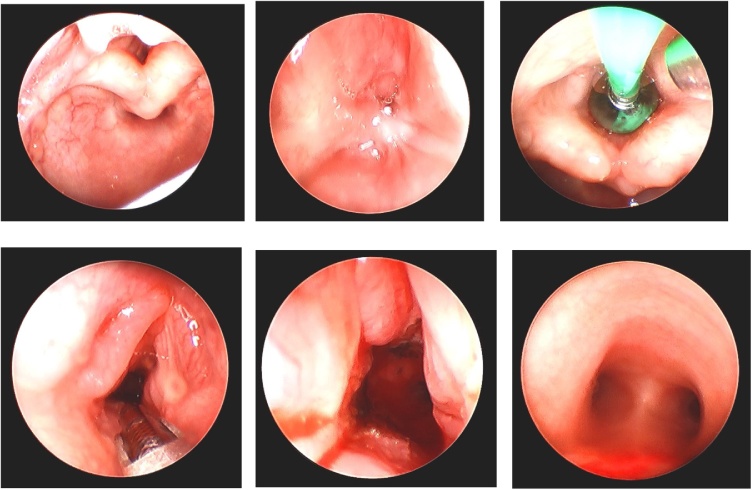
Images - Follow-up Microlaryngoscopy and Bronchoscopy with.CO2 Laser Ablation and Balloon Dilation.